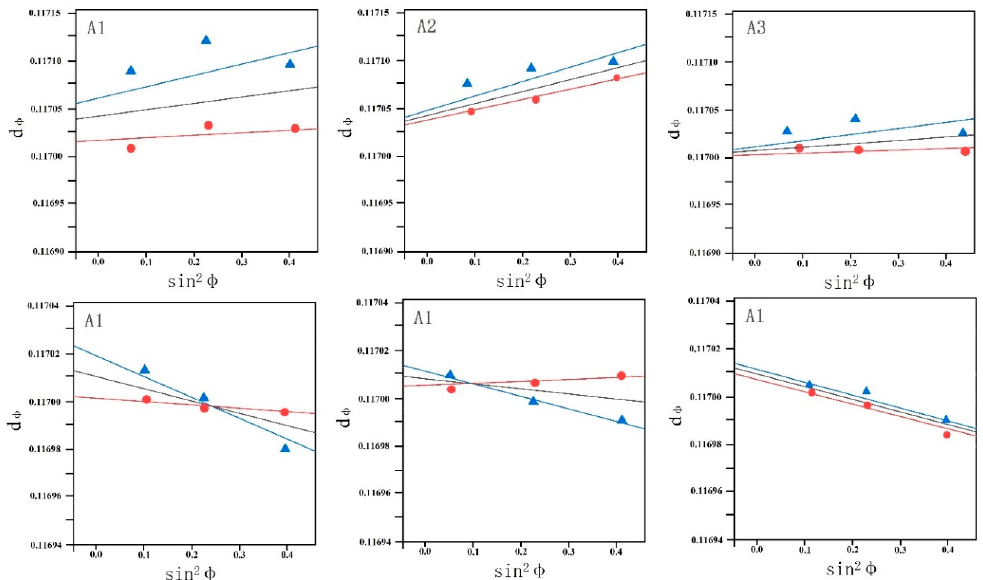
Figure 12. The D φ —sin2 φ curve of each measuring point. Figure 12. The D ϕ —sin2 ϕ curve of each measuring point. Metals 2020 , 10 , x FOR PEER REVIEW